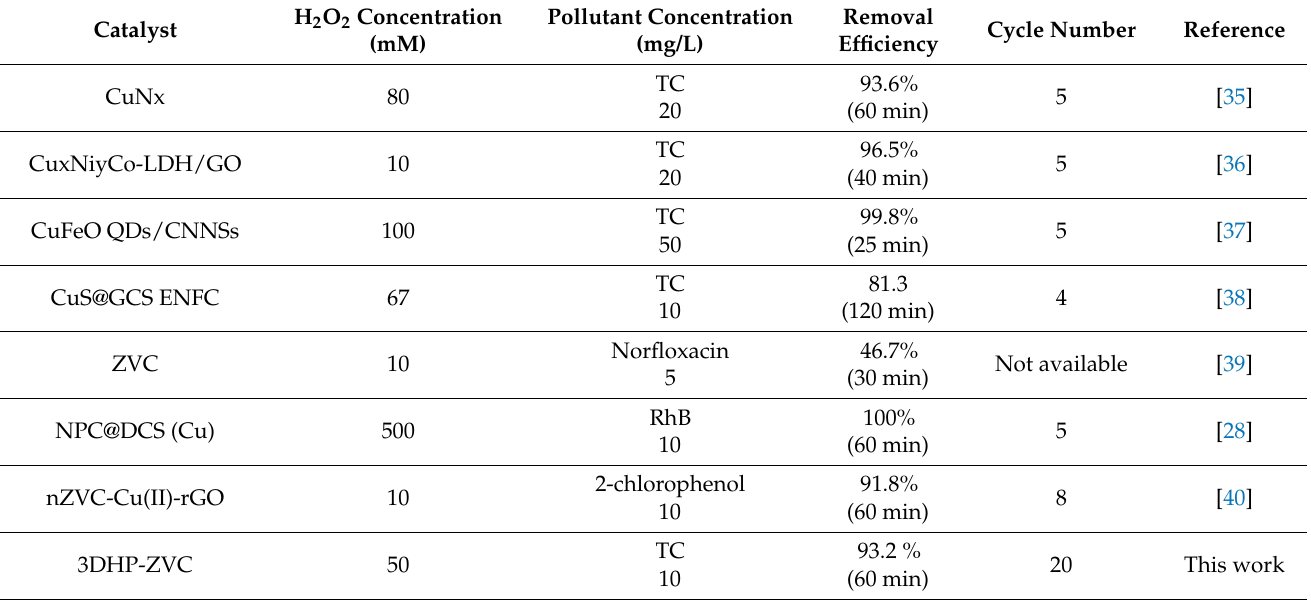
Table 1. Comparison of catalytic activity of various Cu-based catalysts in